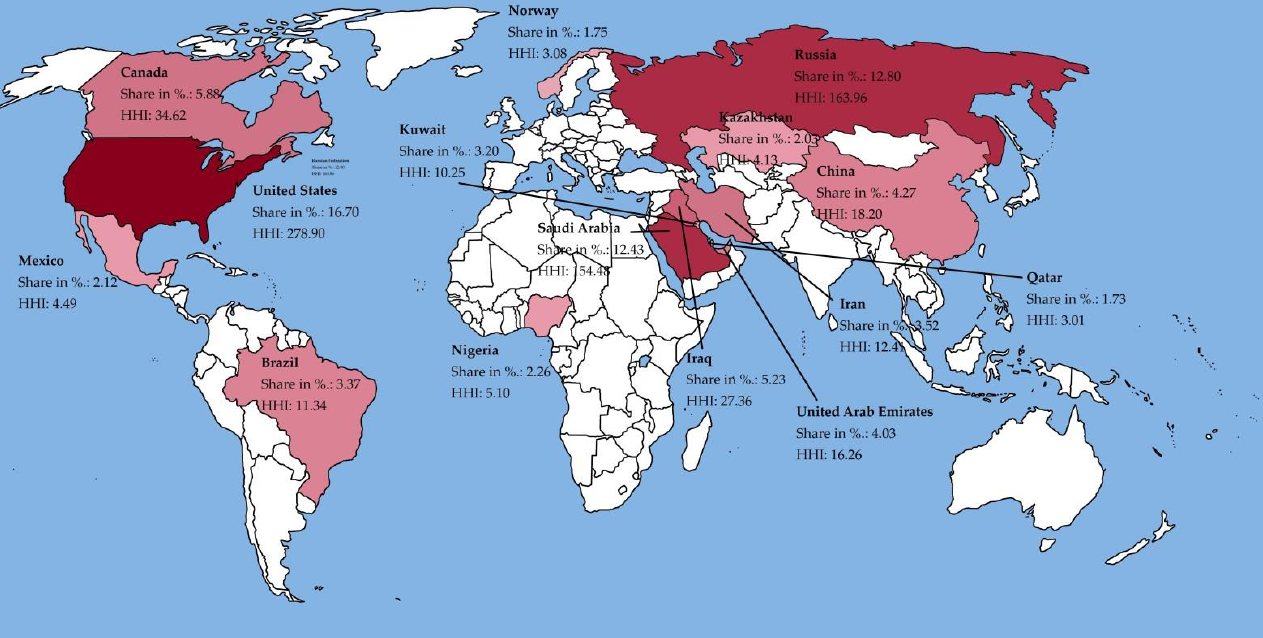
Figure 3. Herfindahl-Hirschman index (HHI) and crude oil production in 2020.